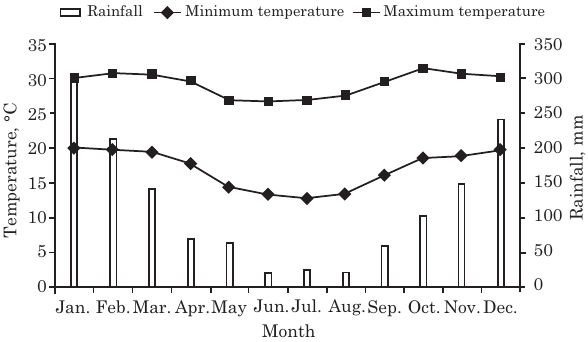
Figure 1. Long-term monthly average maximum and minimum temperatures and rainfall at the experimental site